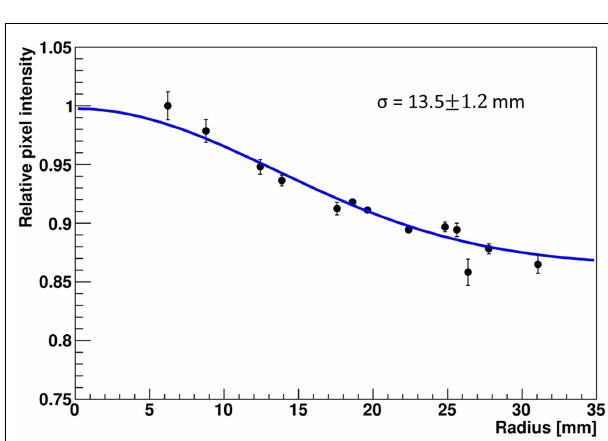
FIGURE 8 | Radial projection of the 2D light amplitude distribution obtained from a central irradiation position of the absorptively wrapped LaBr 3 :Ce detector . In this study, 4 neighboring segments of the 16 × 16 multi-anode PMT were combined. The blue curve represents a Gaussian fit to the data, the resulting width (cid:27) is indicated.